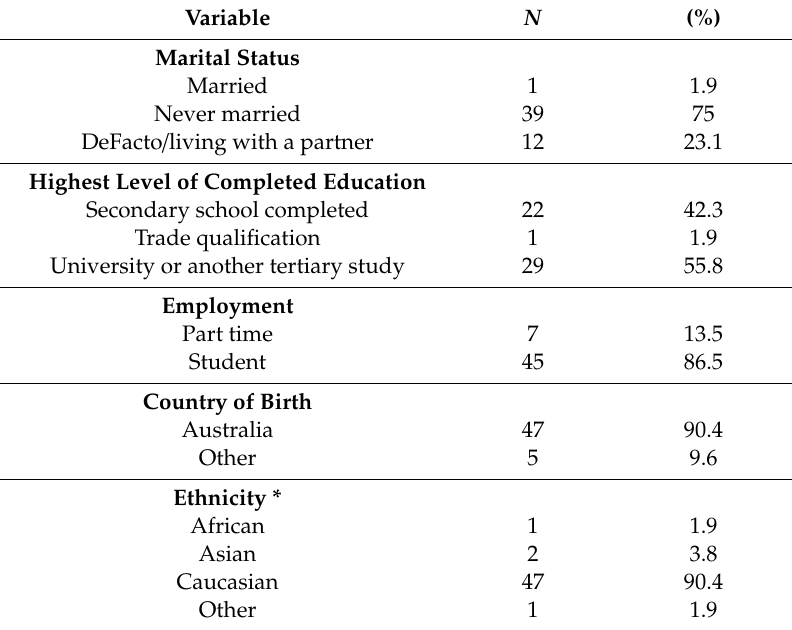
Table 1. Demographic characteristics of